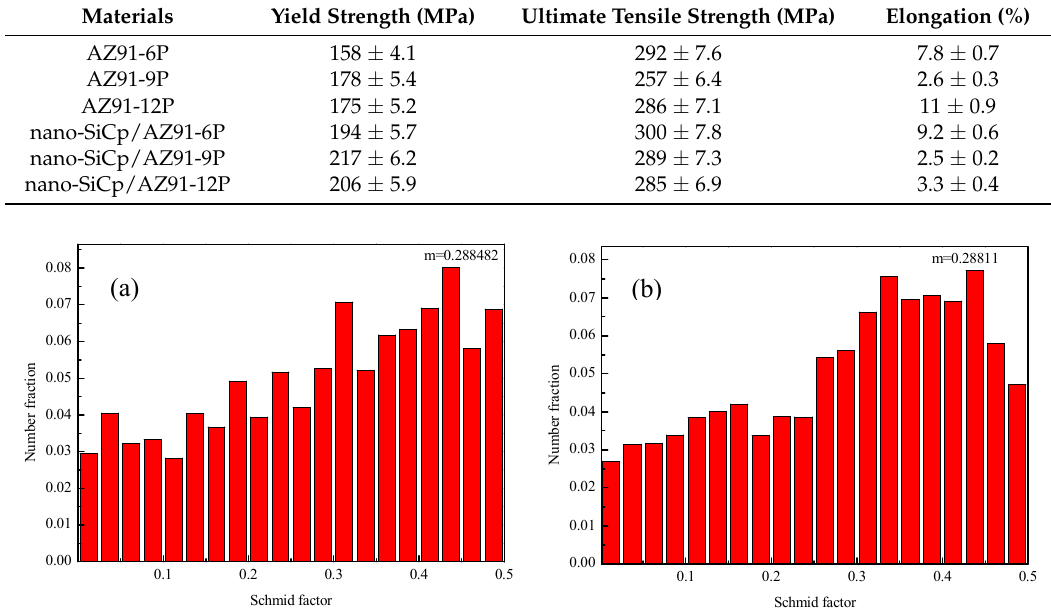
Figure 8. Schmid factors of nano-SiCp/AZ91 composites after multi-pass forging: ( a ) for 9 passes (400-6P + 350-3P), ( b ) for 12 passes (400-6P + 350-3P + 300-3P).